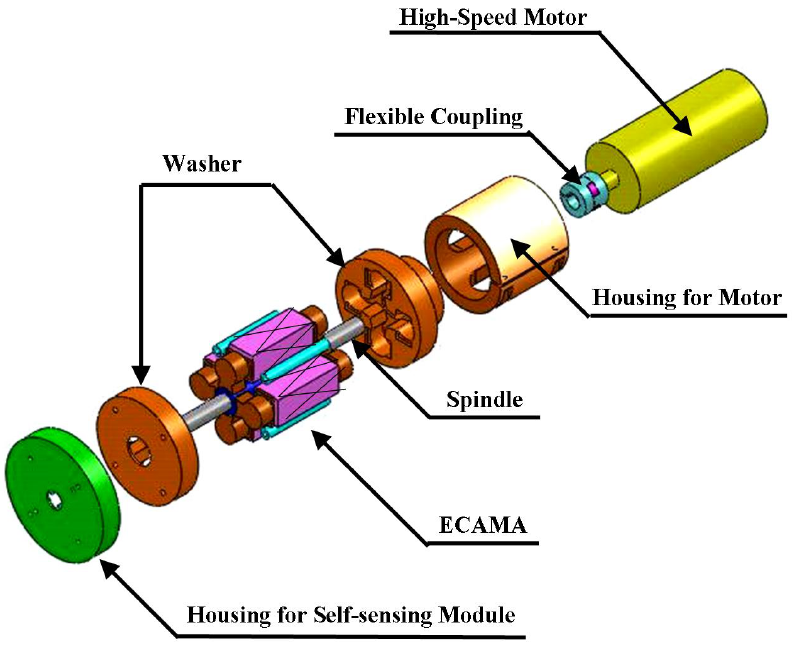
Figure 4. Active magnetic milling module.